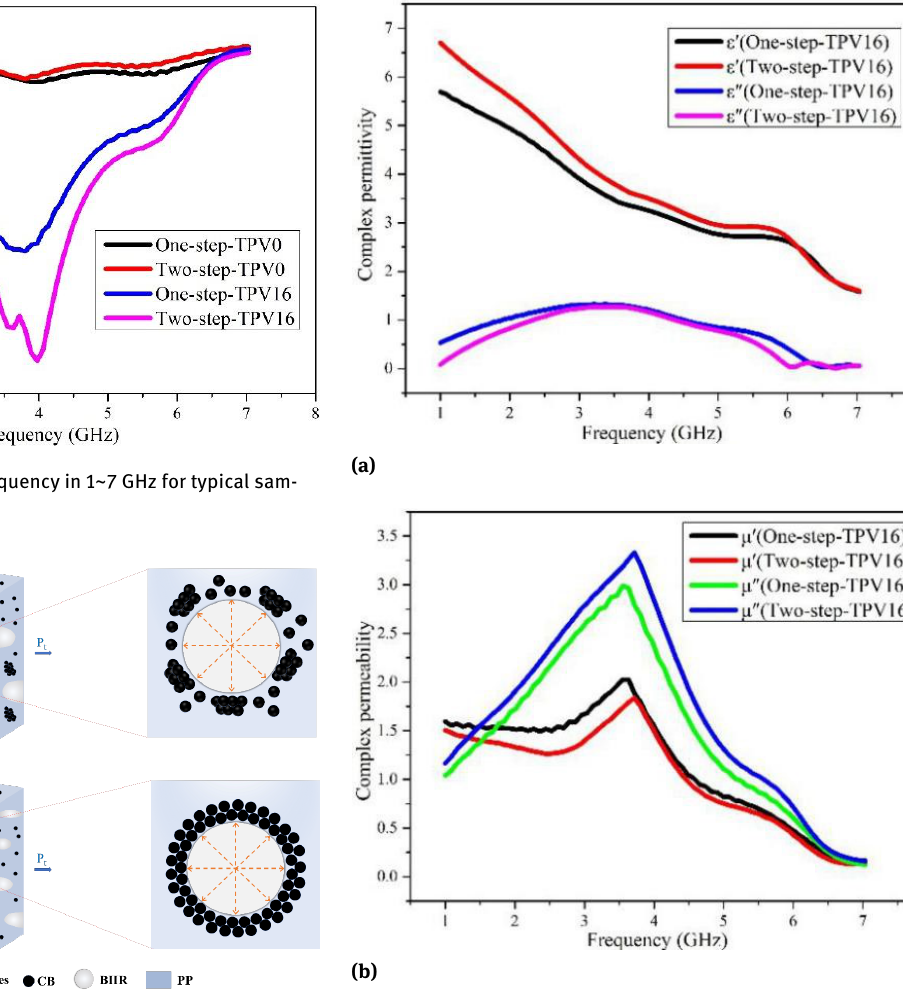
Figure 10: Frequency dependence of (a) complex permittivity and (b) complex permeability of one-step-TPV16 and